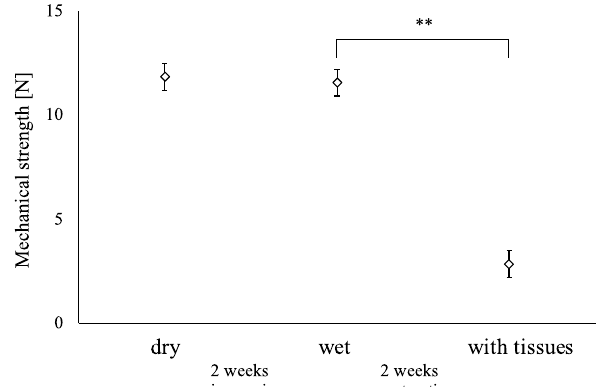
Figure 4. Tensile strength measurement of the glass fiber sheet before and after tissue formation with the developed tensile tester device. **p < 0.01 by two-tailed t-test with an alpha level of 0.05. The error bar relates to the standard deviation of the mean.